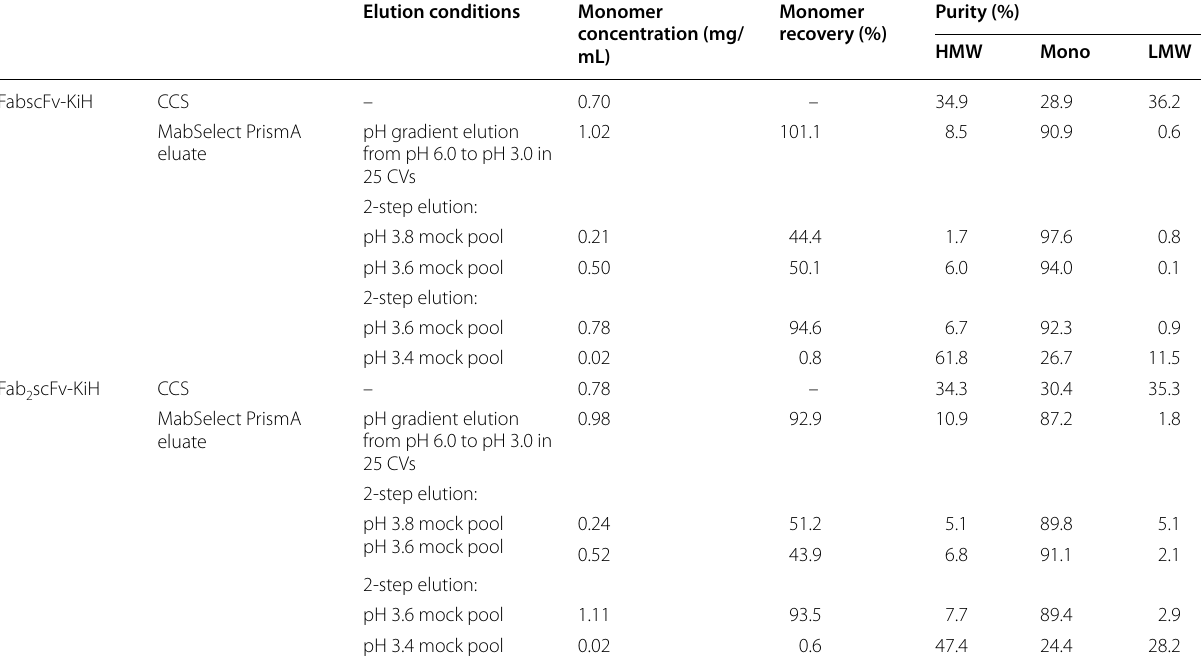
Table 1 Preliminary run for MabSelect PrismA, where 9–10 mg of bsAb monomer containing CCS was loaded per mL of resin, with 3 CVs of 50 mM Na-citrate pH 6.0 wash step followed by their respective elution